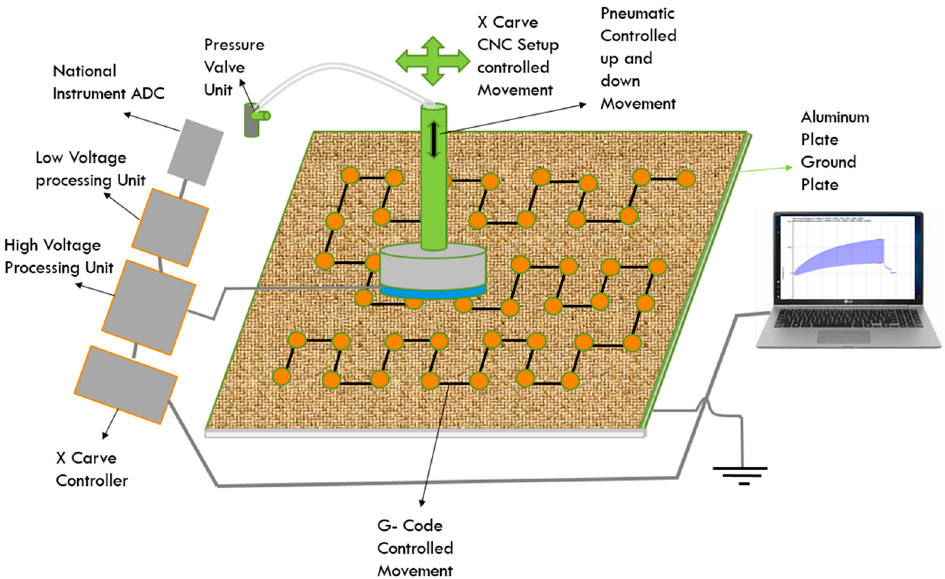
Figure 2. Schematic diagram of electrostatic characterization device.